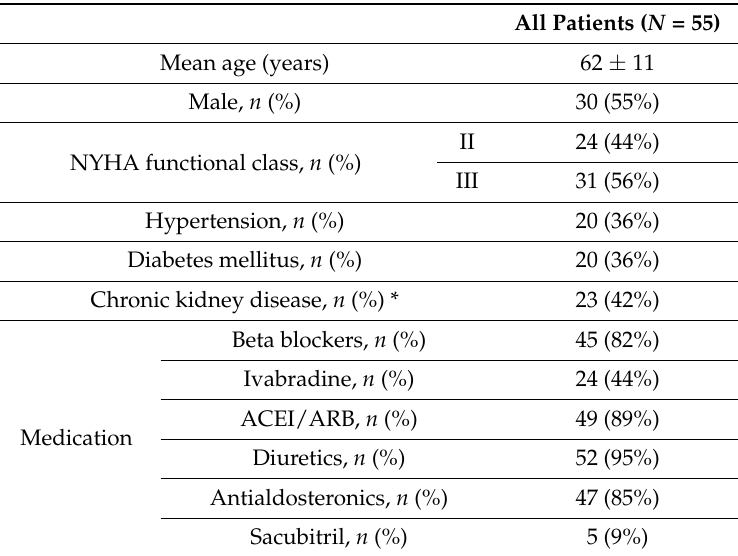
Table 1. Baseline demographic